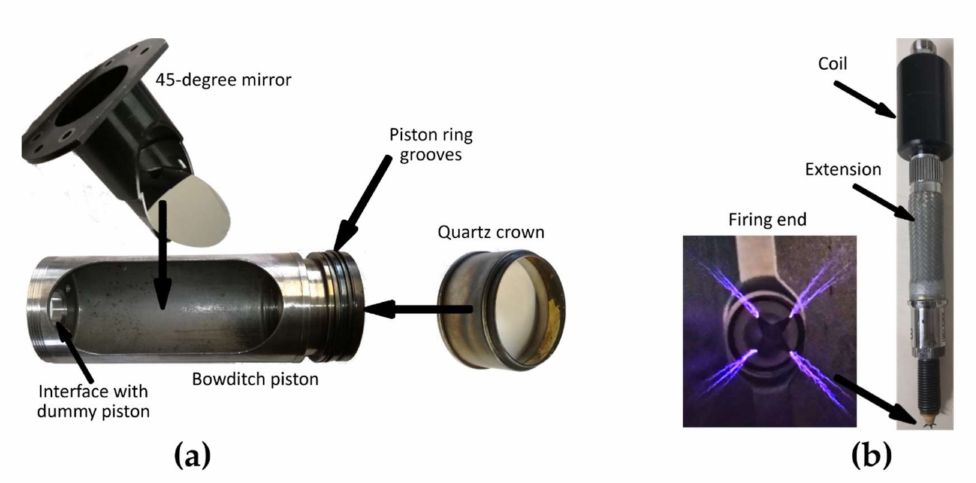
Figure 2. ( a ) Details of Bowditch piston and optical access; ( b ) Advanced Corona Ignition System (ACIS) igniter, with an example of discharge in